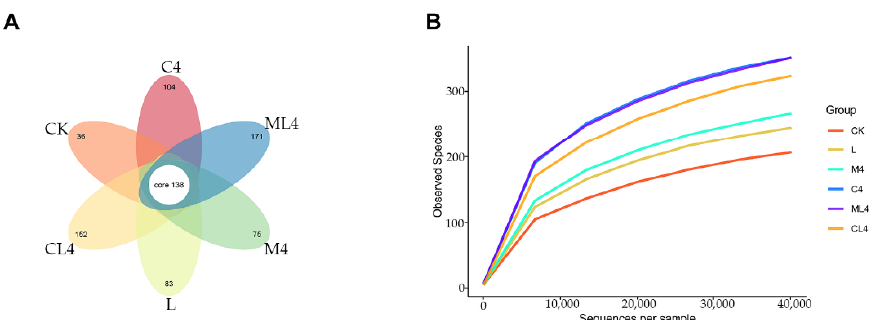
Figure 1. Petal diagram illustrating the degree of overlap of bacterial OTUs among the 6 groups. Each petal represents a group, the middle CORE number represents the number of OTUs common to all groups, and the number on the petal represents the number of OTUs specific to that group ( A ). Rarefaction curves of the observed species index. The horizontal coordinate is the number of sequencing strips selected randomly from a sample, and the vertical coordinate is the number of OTUs that can be constructed based on the number of sequencing strips to reflect the sequencing depth. Different samples are represented by different color curves ( B ).